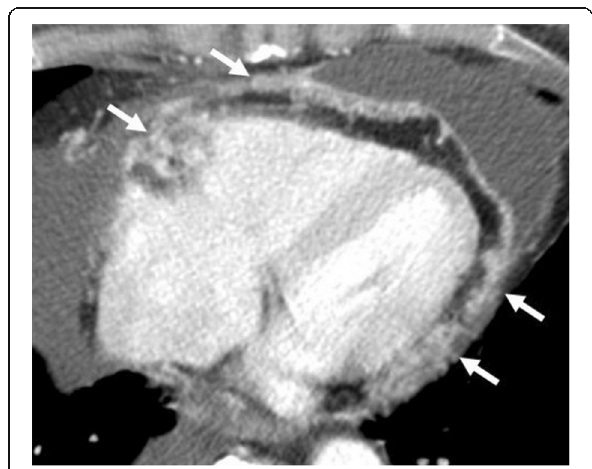
Fig. 18 A 48-year-old woman with pathologically proven renal cell carcinoma. Axial contrast-enhanced CT image demonstrates the diffuse irregular thickening and contrast enhancement of the pericardium (arrows) compatible with pericardial